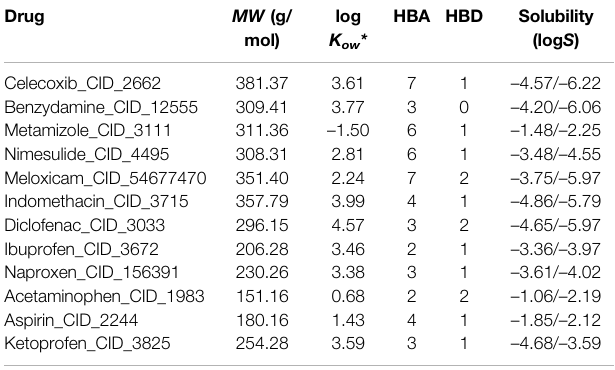
TABLE2| Characteristicsconsideredassociatedwiththebioactivityandsolubility of ligands using the Molinspiration server and the tools of the SIB Molecular Modeling Group | Swiss Institute of Bioinformatics.